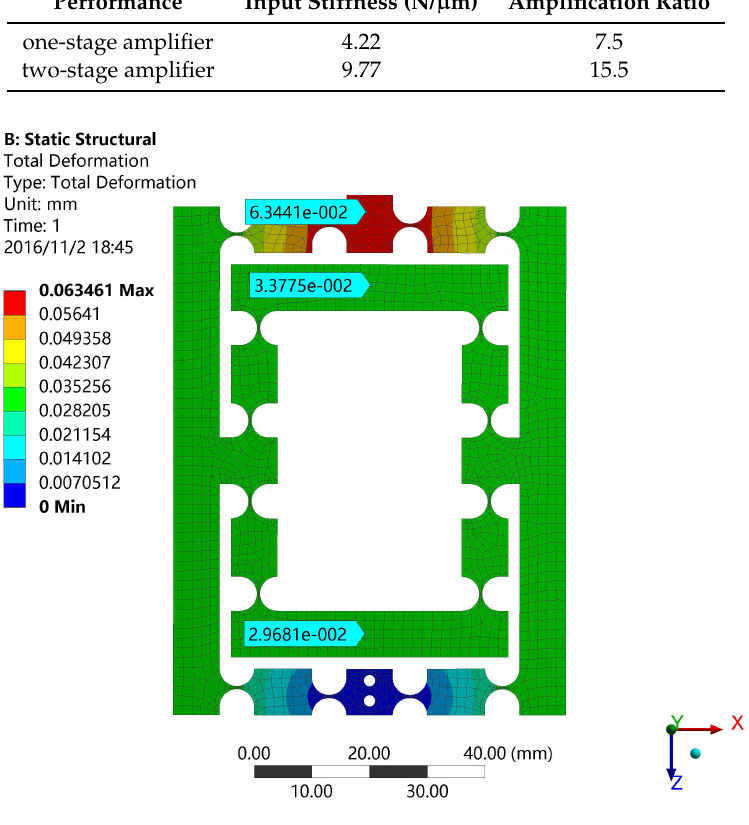
Figure 5. Simulation results of the two-stage amplifier.